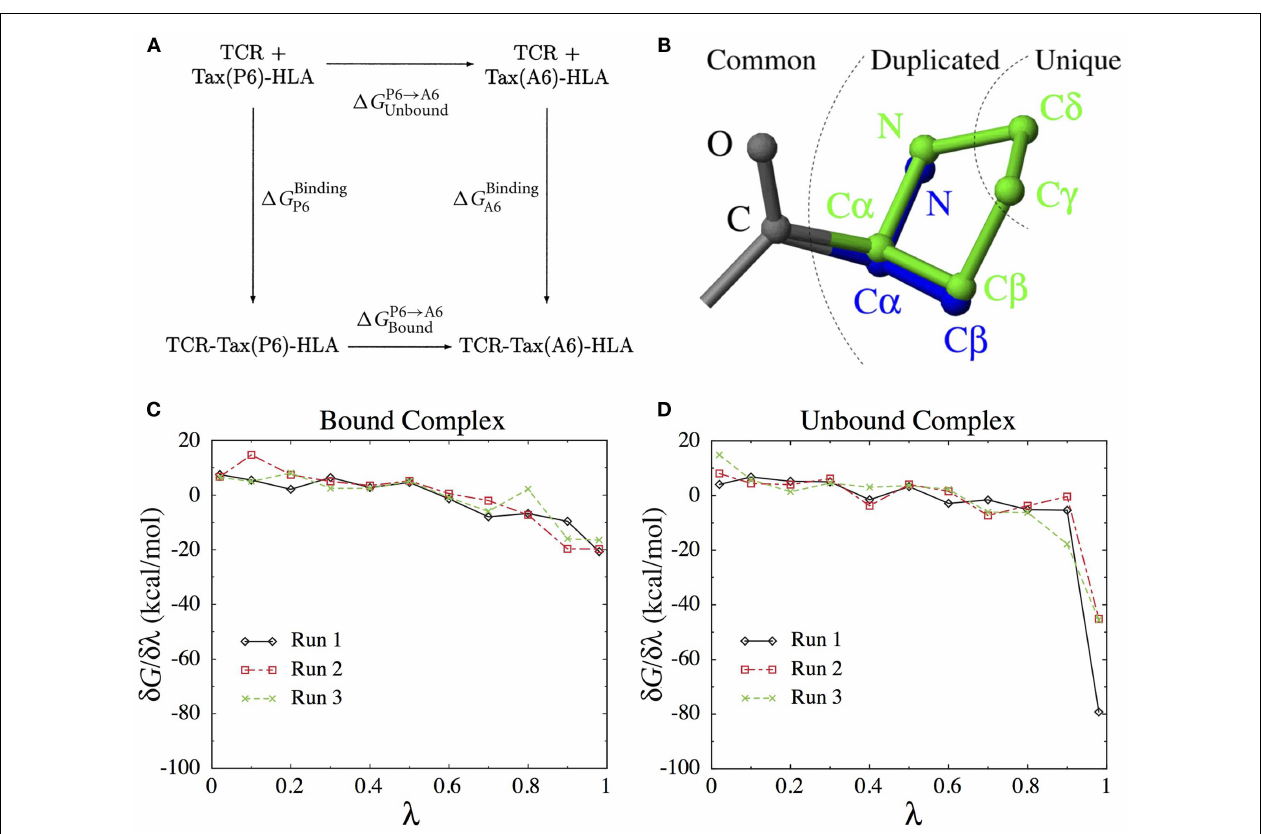
Unique atoms vanish, with their non-bonded interactions switched to zero and their bonded interactions unchanged. (C) Derivatives of the free energy obtained for each λ -value in three independent runs for the bound complex. (D) Idem for the unbound